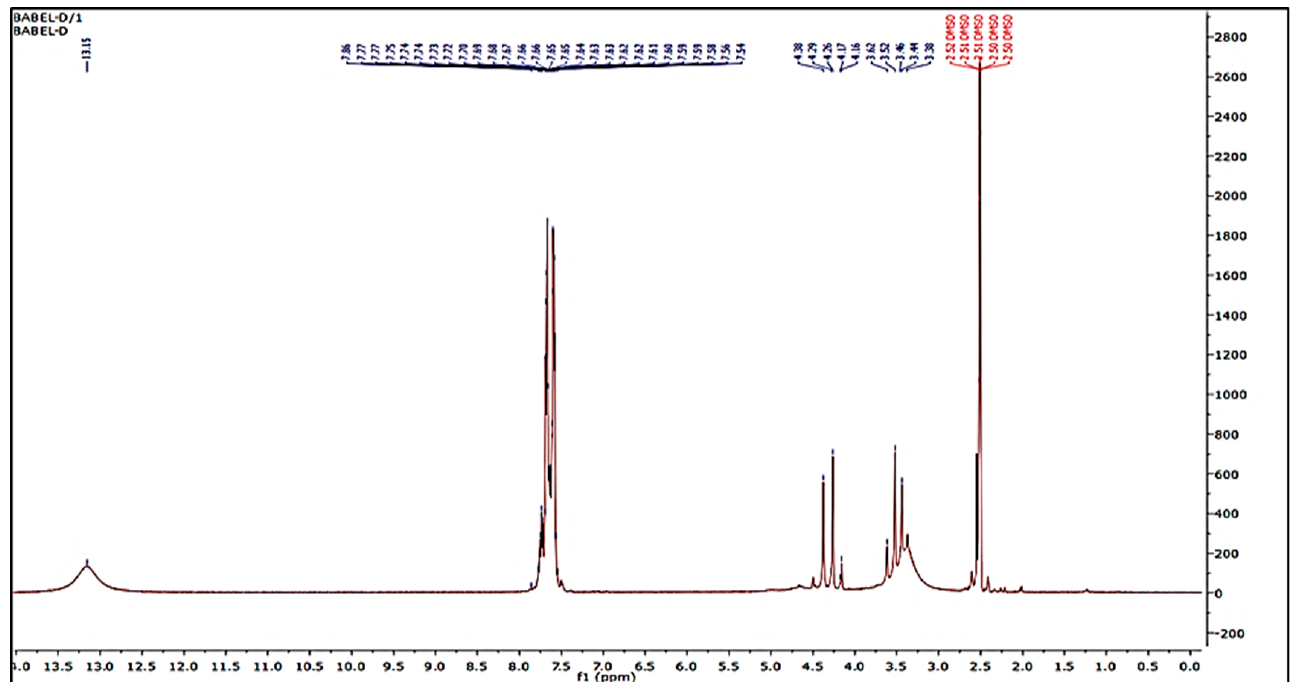
Figure 3. The 1 HNMR spectrum of PMG nanoparticles (f1(ppm): concentration of proton in each peak).